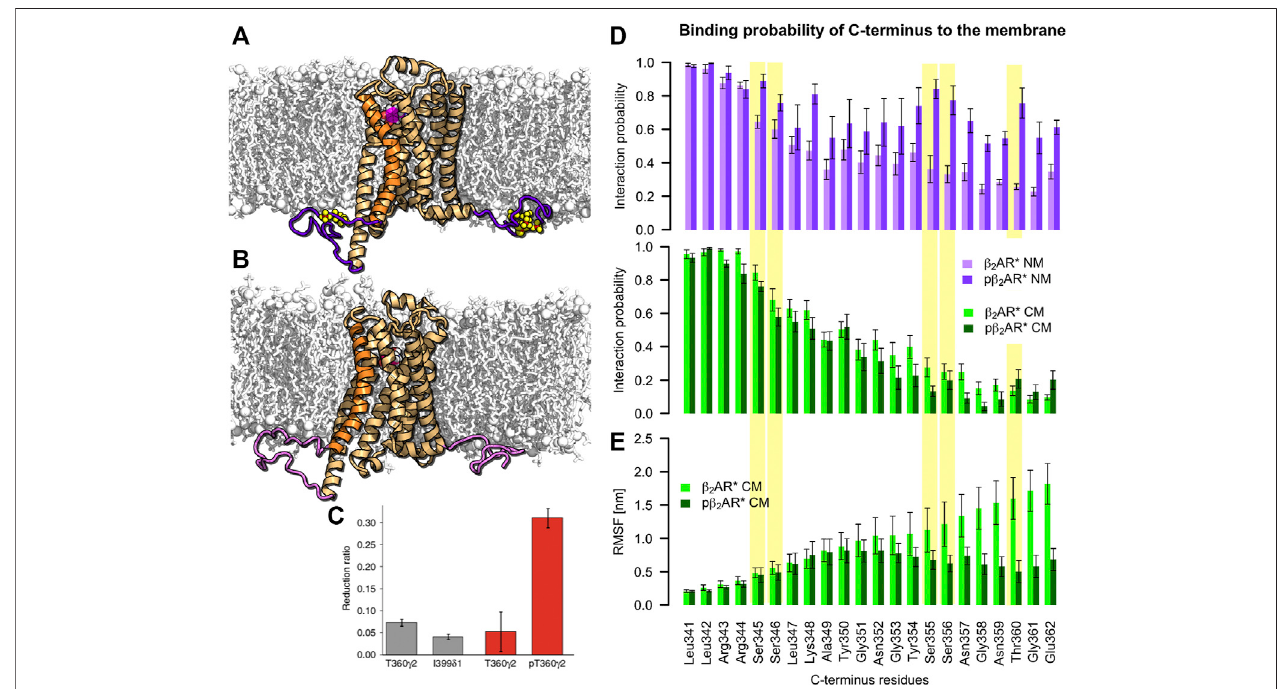
FIGURE 2 | C-terminus interactions with the negatively charged membrane are independent of β 2 AR phosphorylation. (A) Phosphorylated active p β 2 AR* and (B) nonphosphorylated active β 2 AR*(orange cartoonwithTM6highlighted inbrighterorange,ICL3and C-terminus arehighlightedin(light) purple,phosphorylatedresidues are shown as yellow/red spheres) embedded in a neutral membrane (white sticks and spheres) consisting of DOPC, DOPE and cholesterol. Adrenaline is shown as magenta/white spheres. (C) NMR observation ofShiraishi et al. showing phosphorylation induced decrease of fl exibility ofthe C-terminusof β 2 AR* with full agonist formoterol in POPC:POPG 3:2 lipid nanodiscs (Shiraishi et al., 2018). (D) Probability of C-terminus interactions with the neutral (NM, purple colors) and charged (CM, green colors) membranes for active β 2 AR* in different phosphorylation states (nonphosphorylated in light and phosphorylated in dark colors). Yellow background indicates residues that are phosphorylated in the respective data sets. (E) Root mean square fl uctuations (RMSF) per residue along the C-terminus of active β 2 AR* pre andpostphosphorylationdeterminedover500-nsintervalsofstandardMDsimulationsafterexclusionofthe fi rst500nsforequilibrationpurposes.Errorbarsdenotethe SEM [N ( β 2 AR*) (cid:1) 5, N (p β 2 AR*) (cid:1) 9].